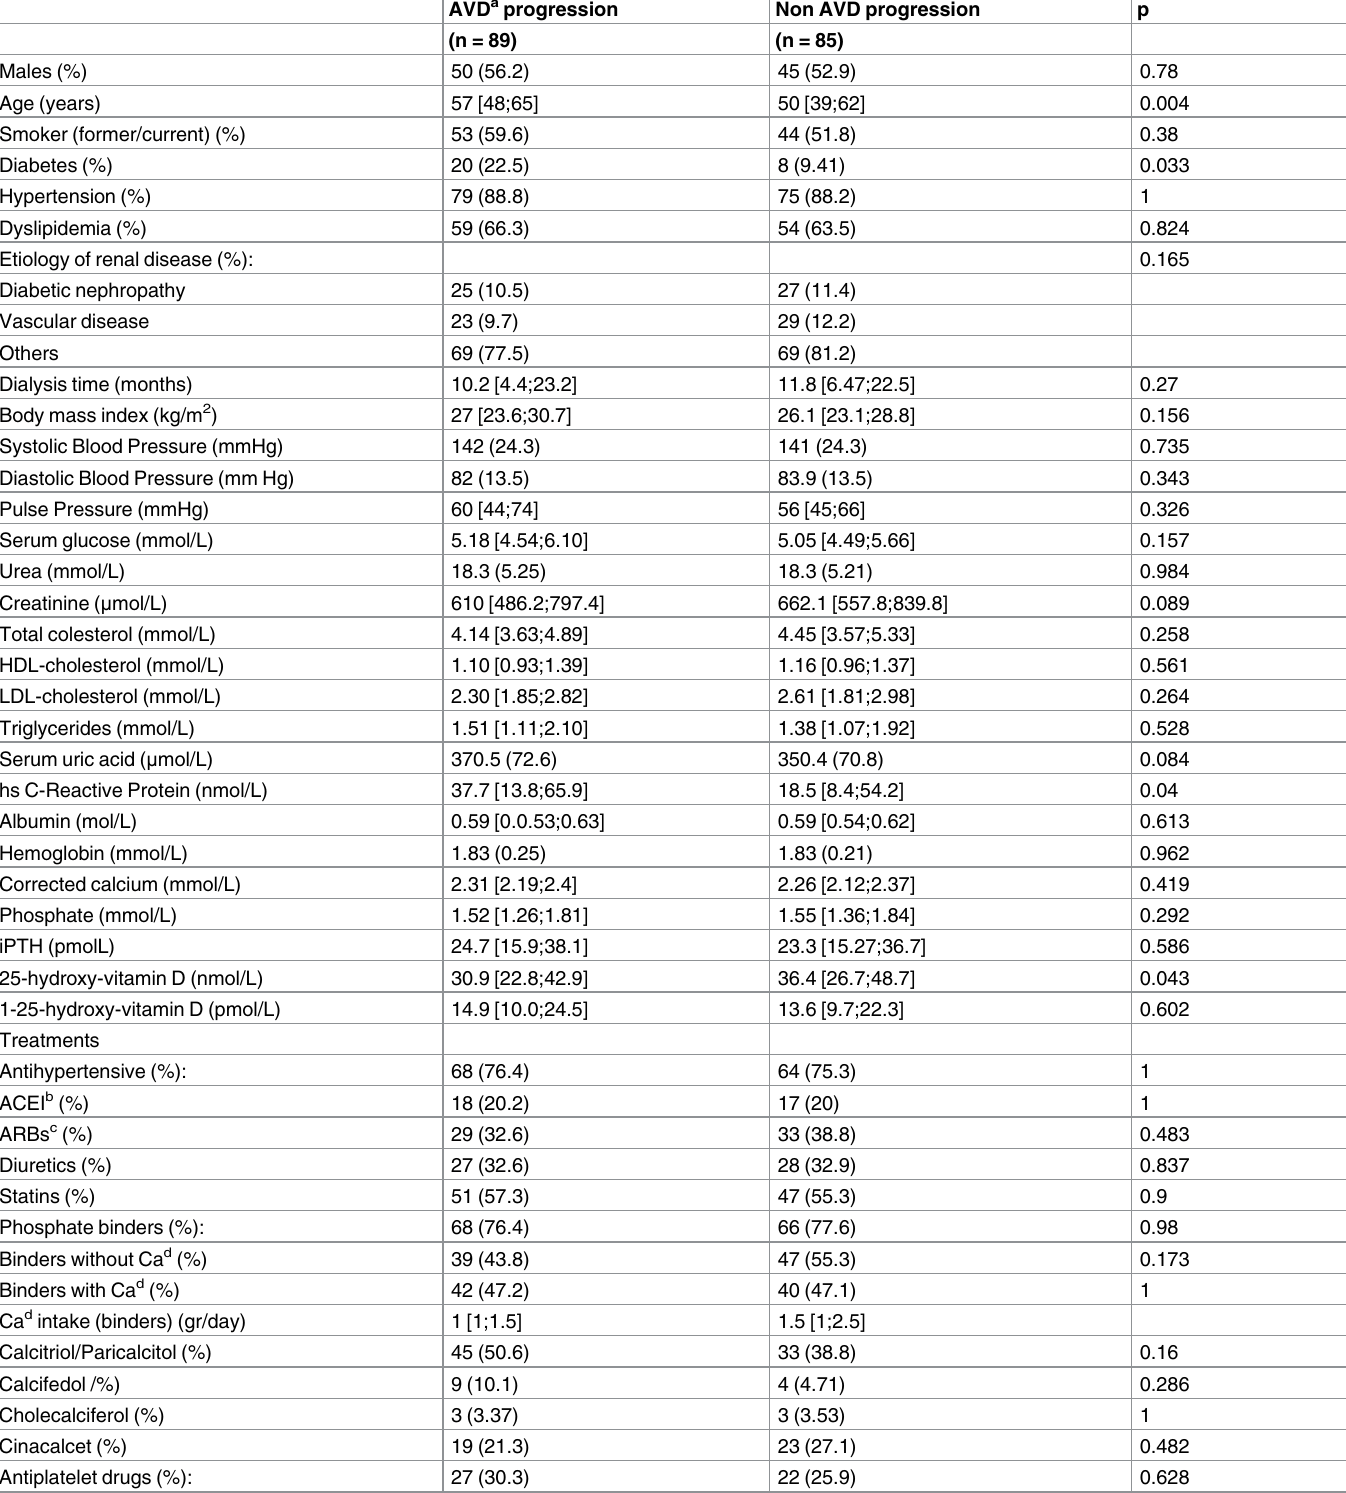
Table 3. Baseline factors associated with progression of atheromatous vasculardisease (AVD) in all